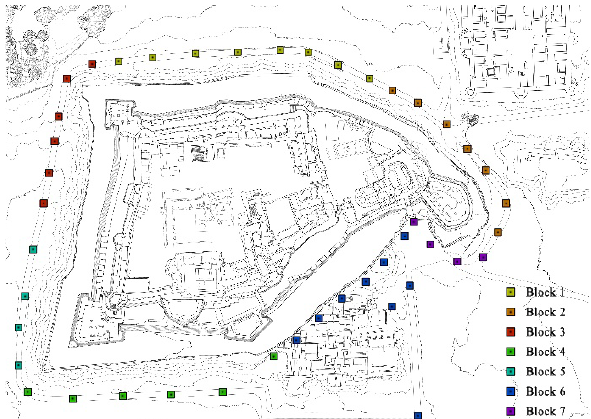
Figure 5. Scans top view with identification of the